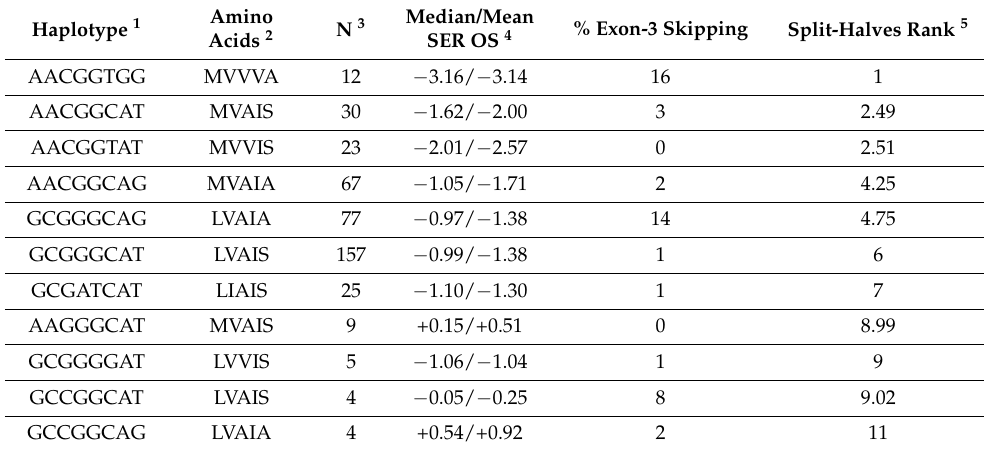
1 Haplotypes are nucleotide identities for dbSNP ID numbers: rs94930, rs713, rs731614, rs5986963, rs5986964, rs149897670, rs145009674, and rs155715655, in that order. 2 Amino acids indicated at protein positions 153,